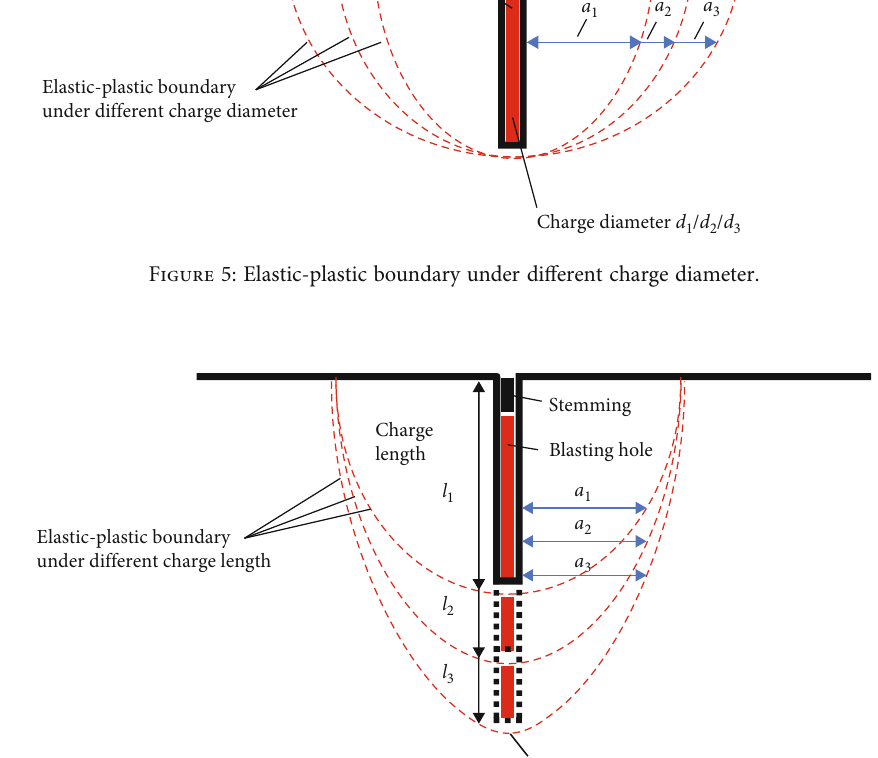
Figure 6: Elastic-plastic boundary under di ff erent charge